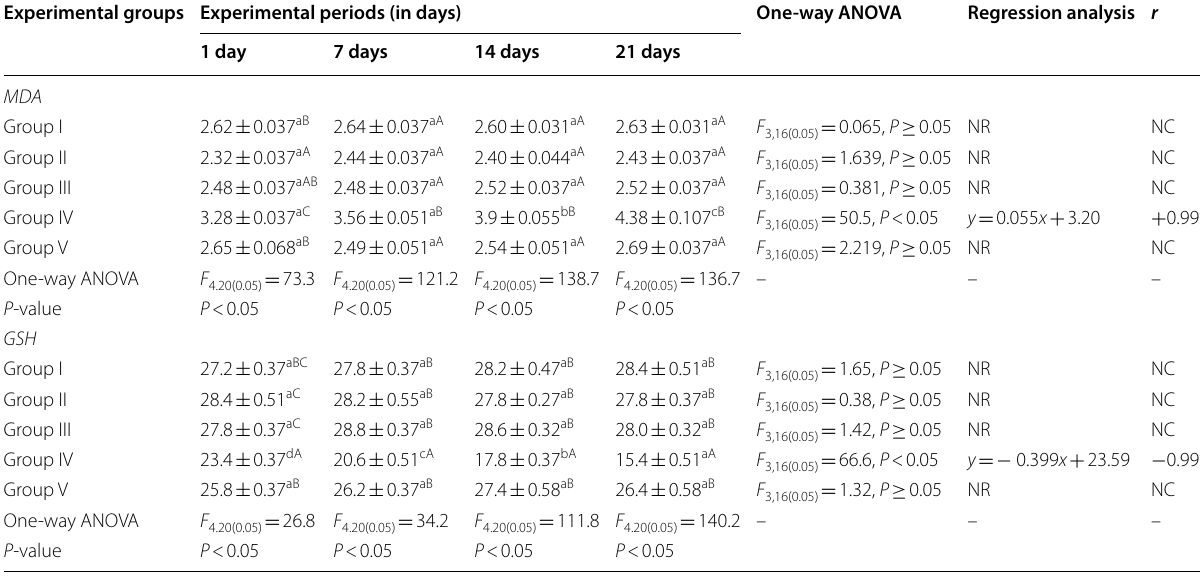
Table 5 The levels of malondialdehyde (MDA, nmol/ml) and glutathione (GSH, mg/ml) in serum of rats in groups I to V, after 1, 7, 14 and 21 days of